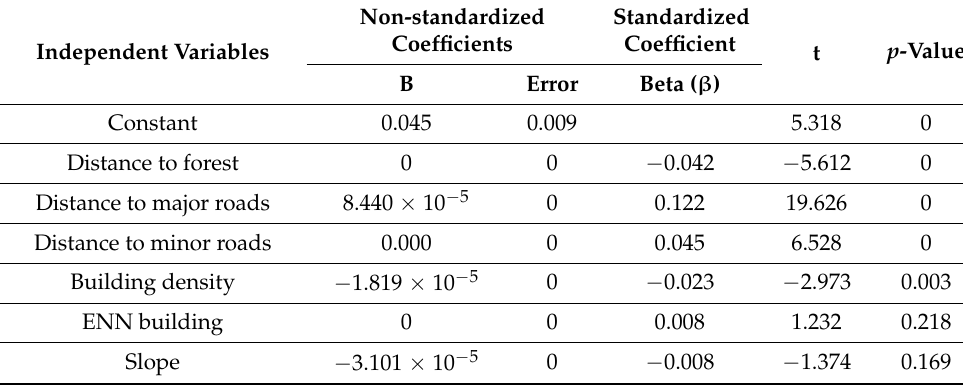
Table 2. Summary of the significance of building scale explanatory variables in the multiple